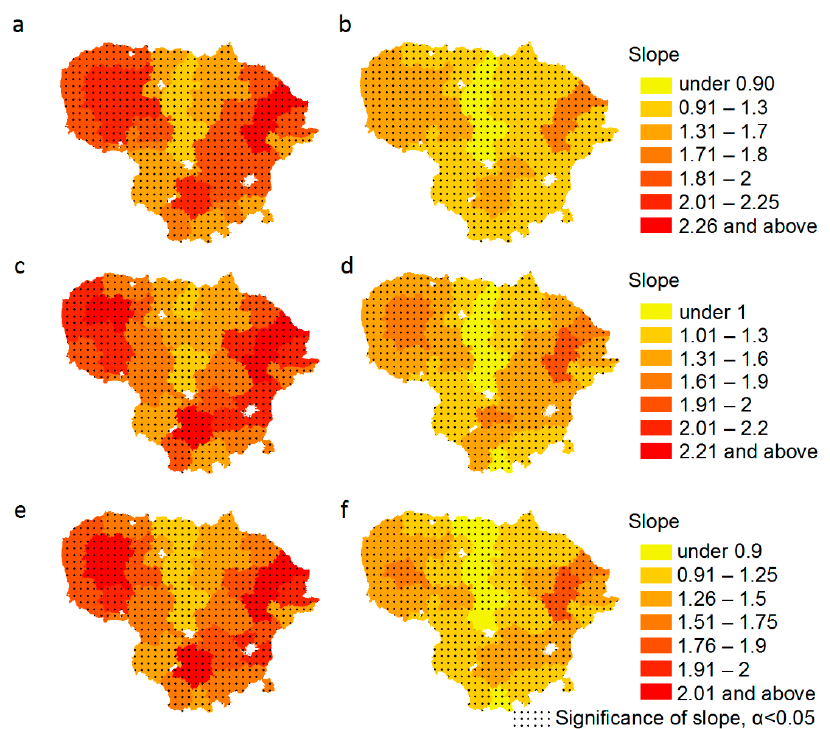
Figure 8. Pattern of climate change effects on volumes of major assortments of harvested timber in Lithuanian forests during the next 100 years from 2020 to 2120: ( a ) Volume of sawlogs harvested annually, REFERENCE scenario, ( b ) volume of sawlogs harvested annually, EU BIOENERGY scenario, ( c ) volume of pulpwood harvested annually, REFERENCE scenario, ( d ) volume of pulpwood harvested annually, EU BIOENERGY scenIo, ( e ) annual volume of harvesting residues, REFERENCE scenario, ( f ) annual volume of harvesting residues, EU BIOENERGY scenario.